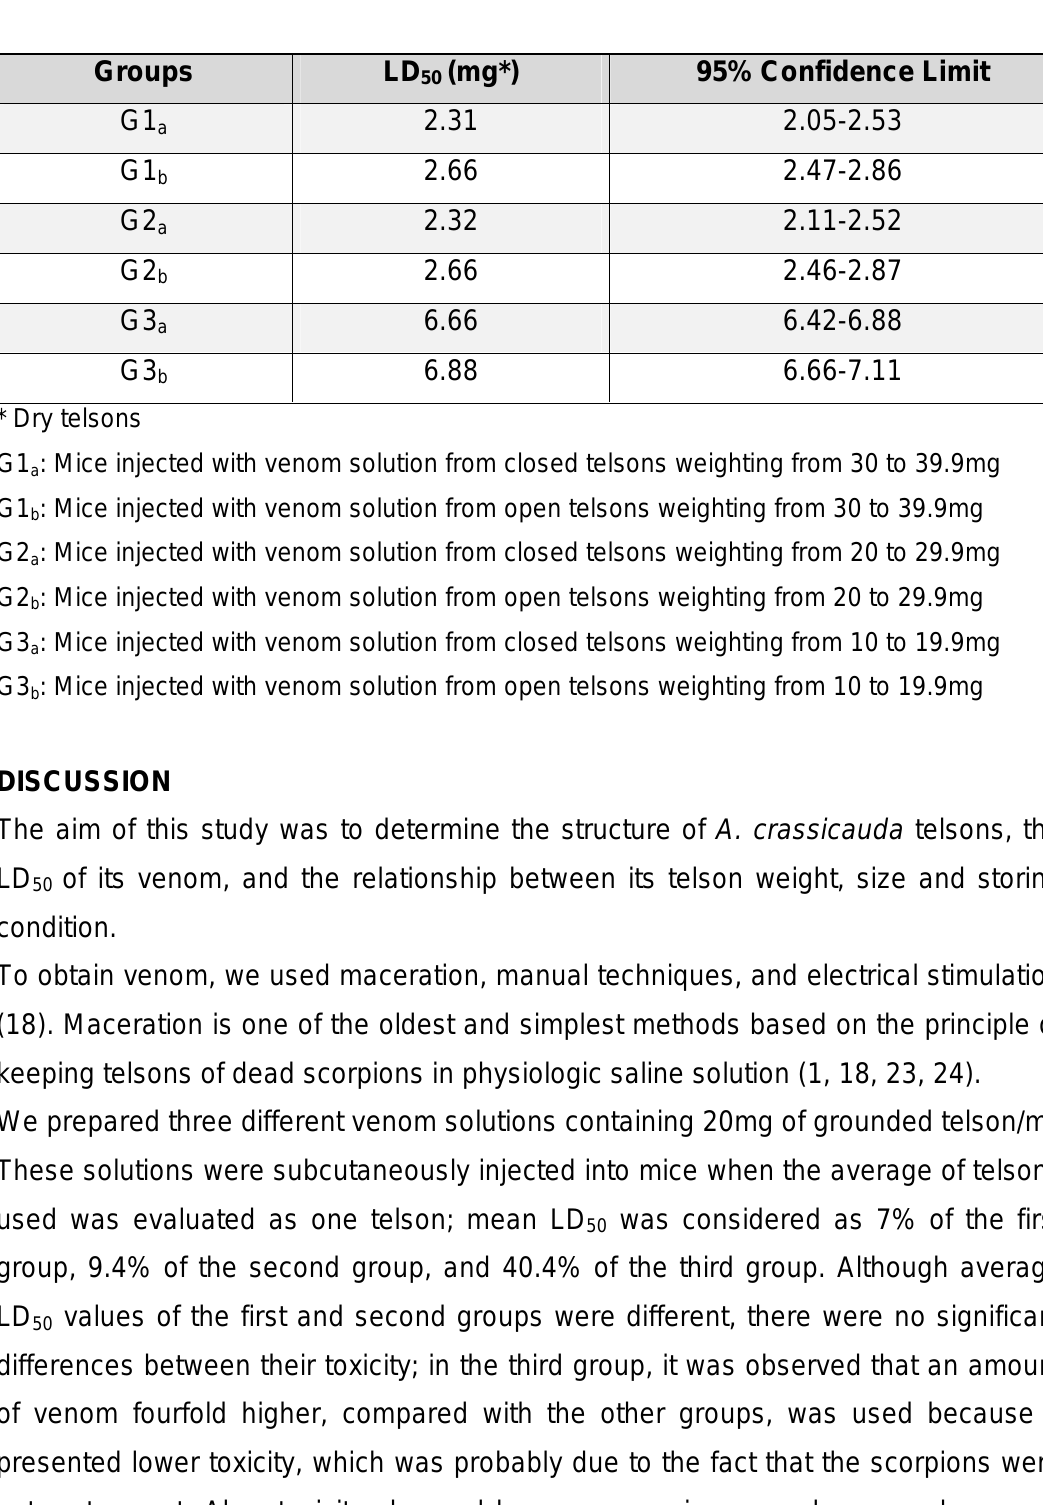
Table 3: Lethal dose 50% (LD ) and confidence limit determined for each group of 50 mice. LD were not significantly different between groups ( p 50